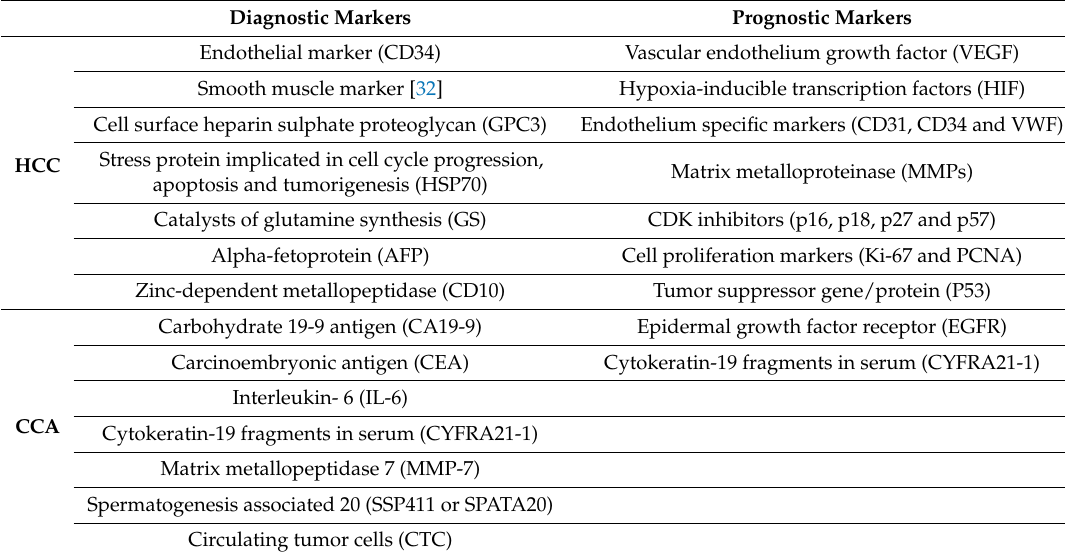
List of the most important diagnostic biomarkers in Hepatocarcinoma (HCC) and Cholangiocarcinoma (CCA). Diagnostic